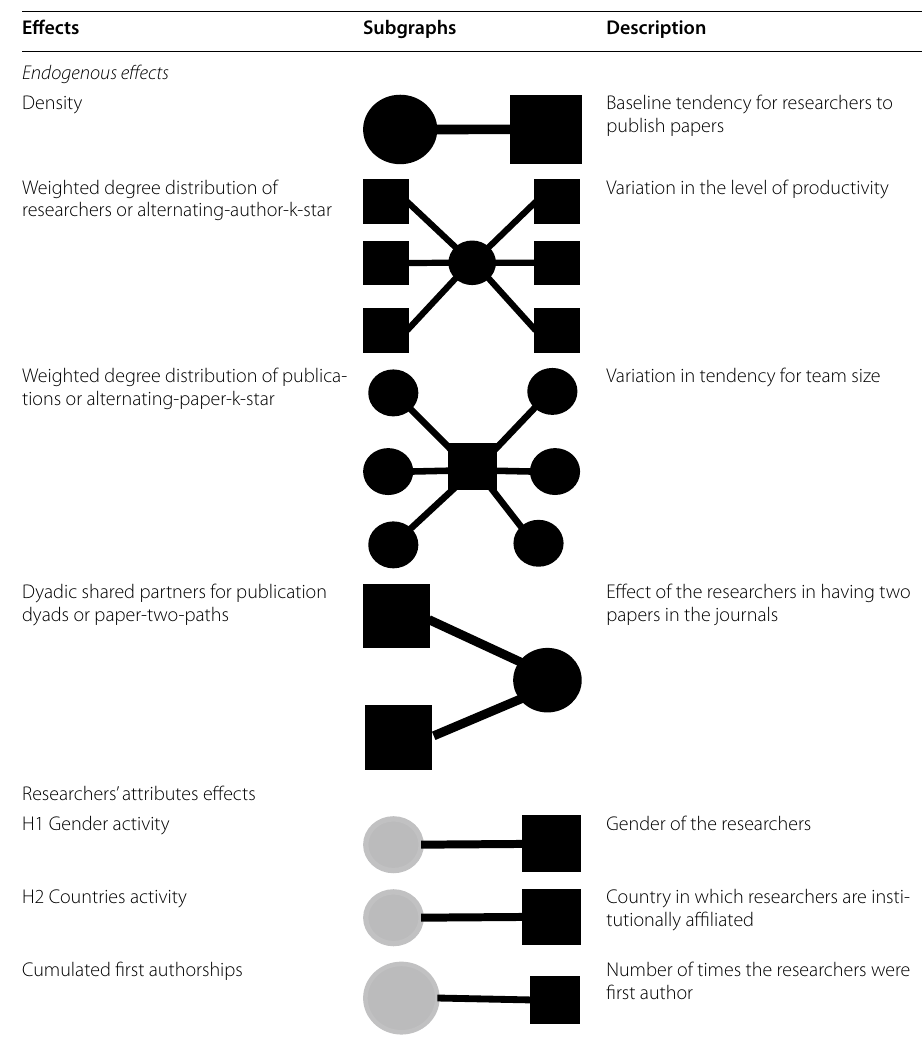
Table 1 Effects for the ERGM